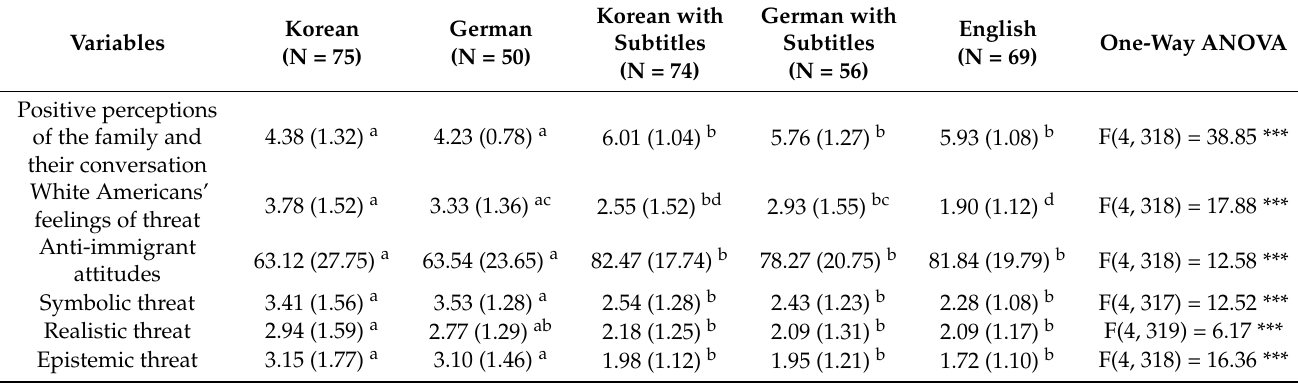
Table 2. Mean scores and standard deviations for main variables (Study